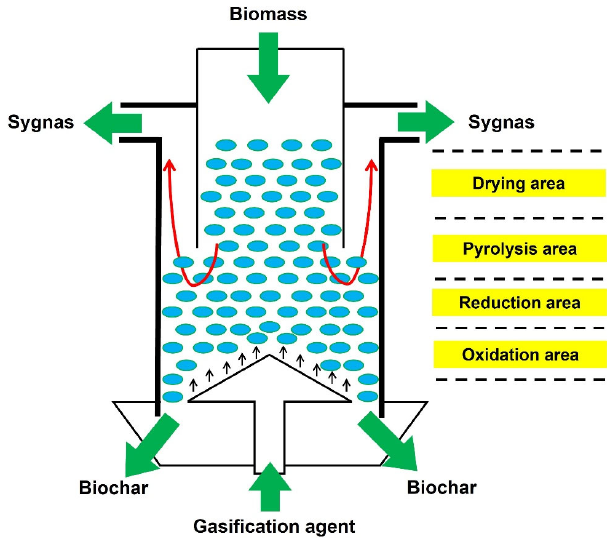
Figure 1. Schematic of improved updraft biomass gasifier.